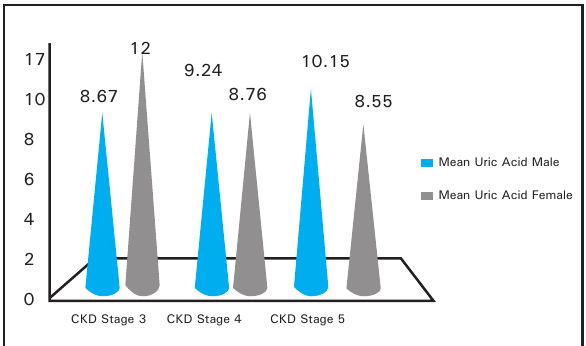
Figure 3. Hyperuricemia in various stages of